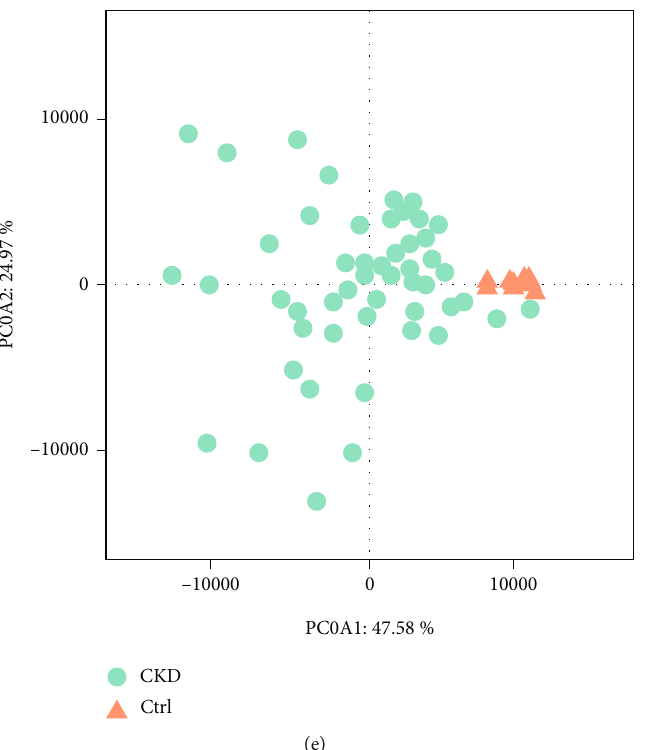
Figure 1: Di ff erential analysis of gene expression pro fi les. (a) The volcano map of GSE62792. (b) The volcano map of GSE66494. (c) The Venn diagram of GSE62792 and GSE66494. (d) The heatmap of di ff erential expression. (e) Principal component